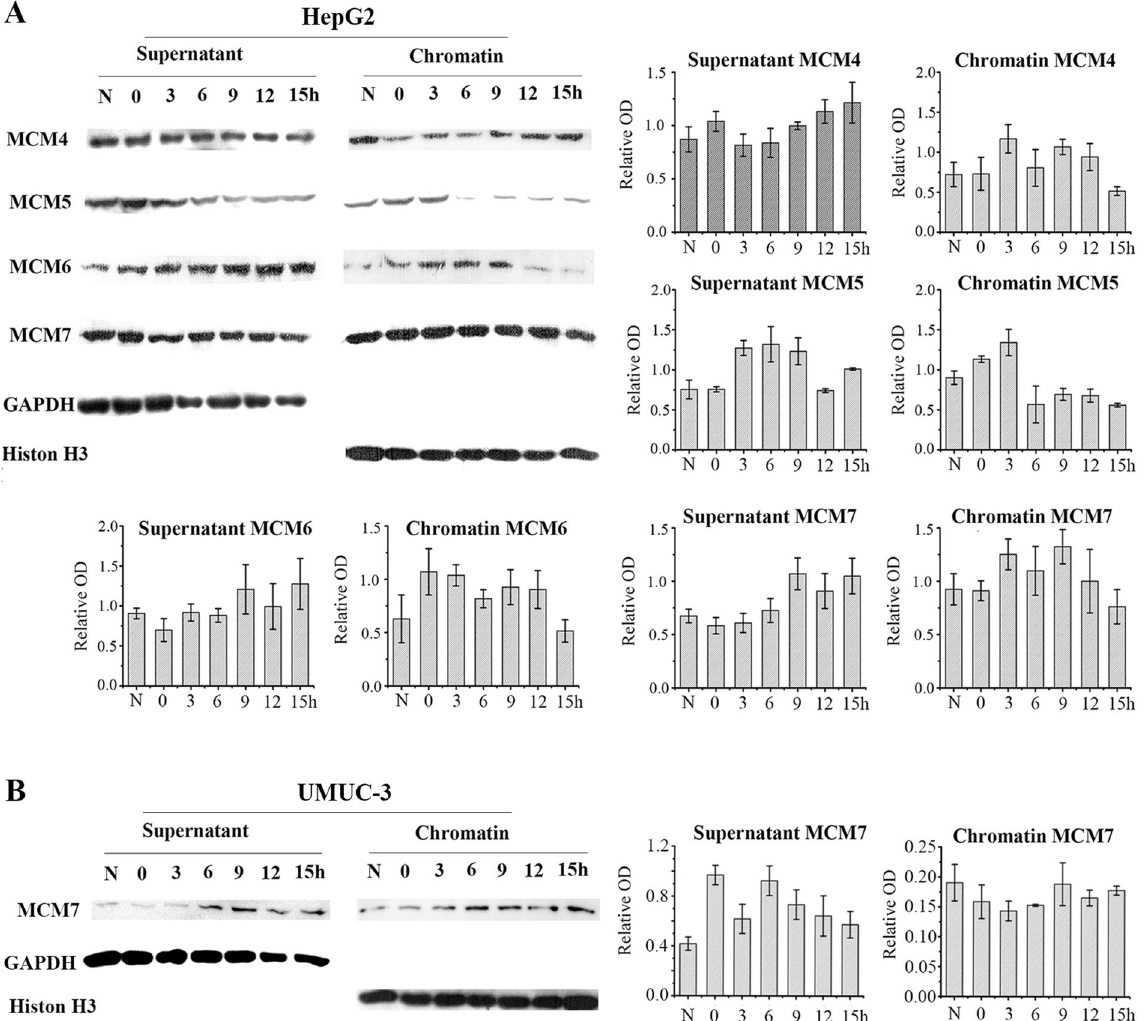
Figure 2. MCM7 keep binding with chromatin in G2/M of HepG2 and UMUC-3 Cells. Cells were treated with double thymine and then incubated in fresh medium for 0 h, 3 h, 6 h, 9 h, 12 h and 15 h. The chromatin binding (chromatin) and non-chromatin binding (supernatant) MCMs in HepG2 cells ( A ) and UMUC-3 cells ( B ) were examined by Chromatin-binding assays. Histone H3 and GAPDH were used as loading control for chromatin- binding proteins and non-chromatin binding proteins respectively. Data are presented as optical density fold difference related to loading control from three independent experiments. N: asynchronized